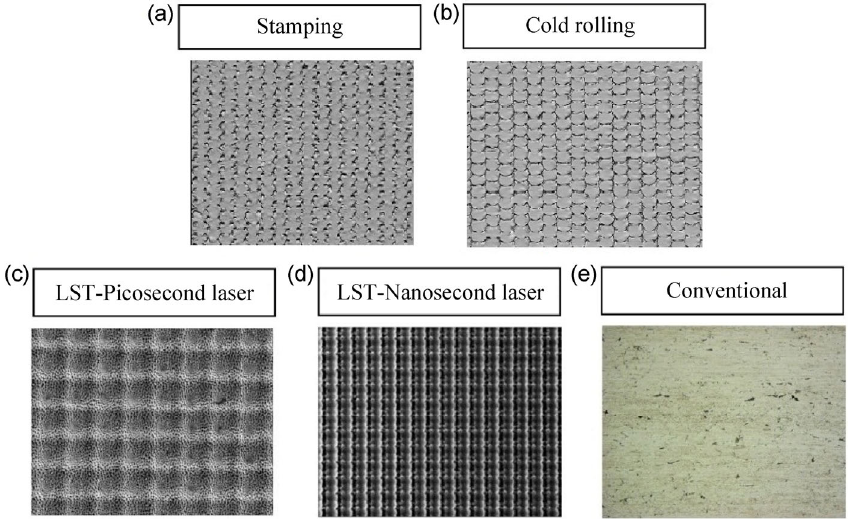
Fig. 2 SEM images of sample (a) 1HV90 (stamping), (b) 1HV90-1% (cold rolling), (c) HDG-1 (LST–Picosecond), (d) LDG-3 (LST–Nanosecond) and (e) 2G